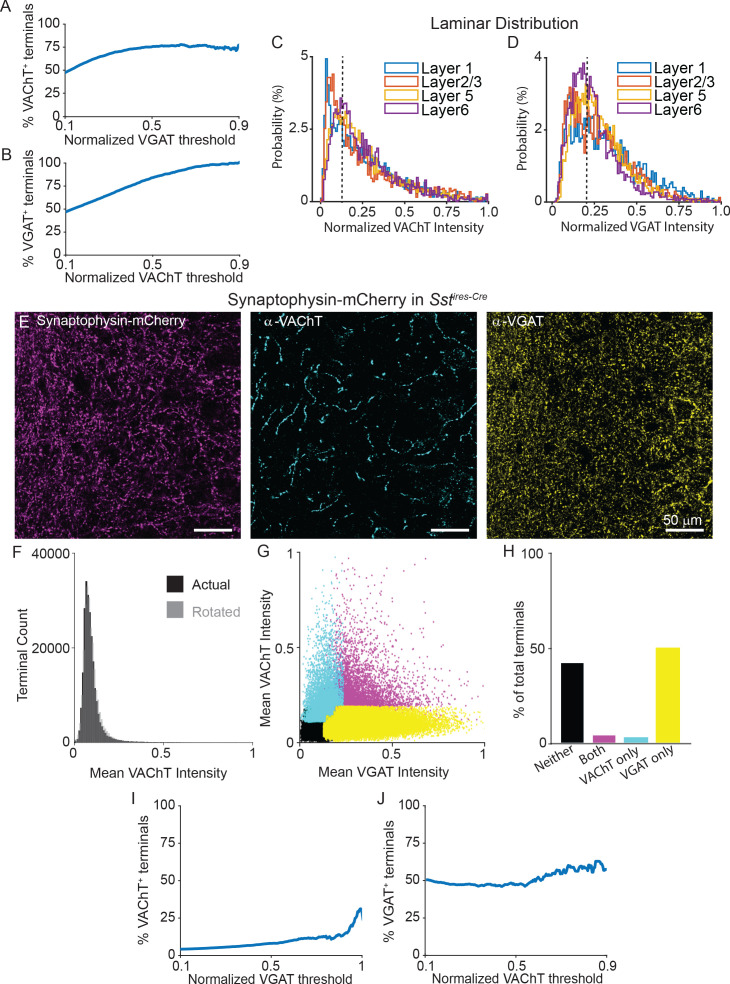
VAChT is present in a subset of terminals across intensity thresholds, and is absent from the terminals of Sst+ interneurons.(A) The percent of terminals that are positive for VAChT (as determined by a mean intensity threshold greater than the Otsu threshold) across a range of VGAT intensity thresholds. As the threshold for VGAT intensity increases, the percent of VAChT+ terminals plateaus around 70%. (B) The percent of terminals that are positive for VGAT (also determined by a mean intensity threshold greater than the Otsu threshold) across a range of VAChT intensity thresholds. The percent of VGAT+ terminals increases to 100% as the VAChT intensity threshold increases. This indicates that there are two main populations of terminals – those that express both VGAT and VAChT, and those that express only VGAT. (C,D) Distribution of VAChT (C) and VGAT (D) intensity within each terminal across cortical layers in motor cortex. Dashed vertical lines indicate the threshold for classifying terminals as VAChT or VGAT positive. VAChT+ terminals are not uniformly distributed across layers (VAChT+ terminals: 64.25% (1643/2557) in layer 1, 59.35% (15552/2615) in layer 2/3, 70.73% (4137/5849) in layer 5, and 71.21% (3166/4446) in layer 6; p=3.1×10−10, Pearson’s Chi-squared test), and VGAT terminals are not uniformly distributed (VGAT+ terminals: 67.32% (1333/1980) in layer 1, 62.86% (1481/2356) in layer 2/3, 66.72% (3304/4952) in layer 5, 55.80% (2405/4310) in layer 6; p=1.6×10−11, Pearson’s Chi-squared test). (E) Example images of Sst+ pre-synaptic terminals labeled with AAV(8)-DIO-Synaptophysin-mCherry injected into the cortex of Sstires-Cre mice. Left: Synaptophysin-mCherry; Middle: VAChT immunostain; Right: VGAT immunostain. (F) Histogram of mean VAChT fluorescence intensity within Synaptophysin-mCherry+ pre-synaptic terminals of Sst+ interneurons. Black histogram represents the actual VAChT intensities, the grey histogram represents the mean VAChT intensities when the mCherry+ image mask is rotated 90° relative to the VAChT immunostain image. (G) Scatter plot of mean VGAT and VAChT intensity in each putative mCherry+ pre-synaptic terminal (n = 249,899 putative terminals from 14 image stacks from 2 Sstires-Cre mice). Terminals are color-coded according to expression of VAChT and VGAT (Black – neither VGAT or VAChT, Magenta – both VGAT and VAChT, Cyan – VAChT only, Yellow – VGAT only). (H) Quantification of the number of terminals of each type in (E). (I,J) The percent of VAChT+ terminals (G) and VGAT+ terminals (H) across a range of VGAT and VAChT intensity thresholds, respectively. As VGAT intensity threshold increases, there is no relationship with the percent of terminals that are VAChT+ (G). Likewise, as VAChT intensity threshold increases, there is no relationship with the percent of terminals that are VGAT+ (H).